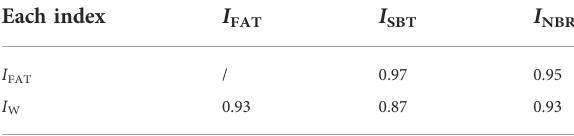
TABLE 1 The correlation coef fi cients of I FAT , I SBT , I NBR , and I W . Each index I